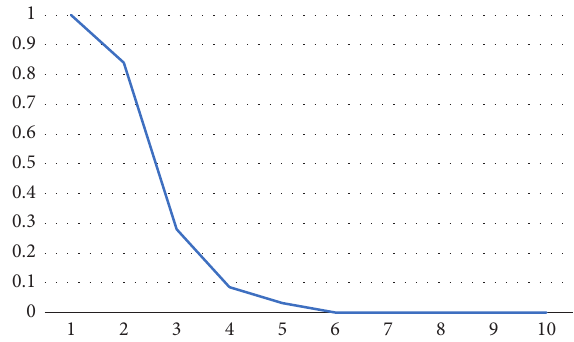
Figure 1: The variation of nearest neighbor error rate of Dow Jones industrial index with embedding